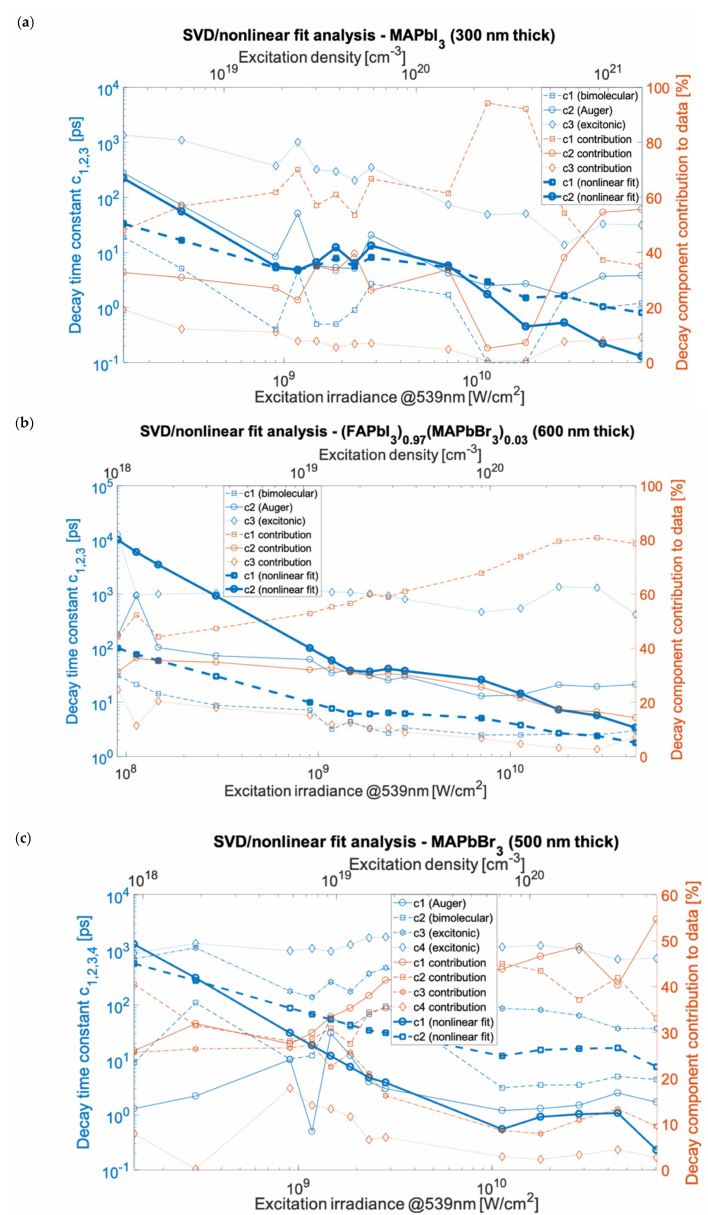
Figure 3. SVD analysis of kinetics for MAPbI 3 with 1500 cm − 1 probe ( a ), (FAPbI 3 ) 0.97 (MAPbBr 3 ) 0.03 with 1713 cm − 1 probe ( b ), and for MAPbBr 3 with 1500 cm − 1 probe ( c ). The decays time constants c 1,2,3,4 and their contribution to data correspond to: c 1,2 —Auger or bimolecular recombination, c 3 —trapped-exciton recombination, c 4 —exciton/biexciton or polaron recombination (symbols depict measurement